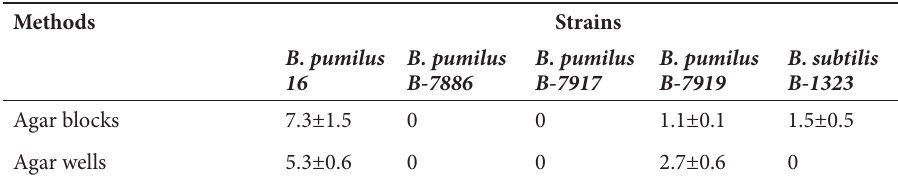
Table 3. Radii of growth inhibition zones (mm (x ± SD) of E. coli by B. pumilus 16 and type strains